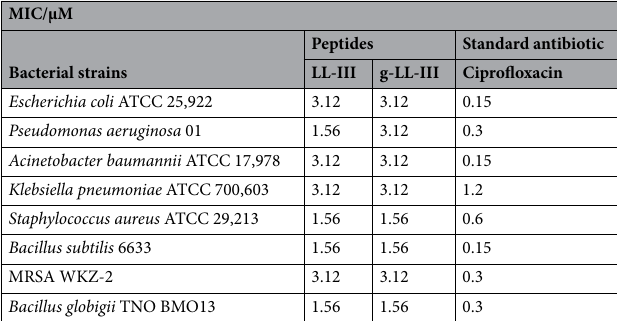
Table 2. Minimal inhibitory concentrations (MIC, in µM) of g-LL-III and LL-III against the reported bacterial strains.